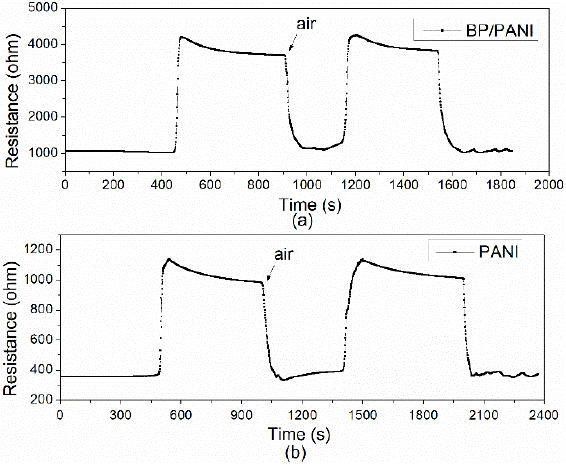
Figure 7. Typical response and recovery curves of ( a ) PANI and ( b ) BP/PANI.